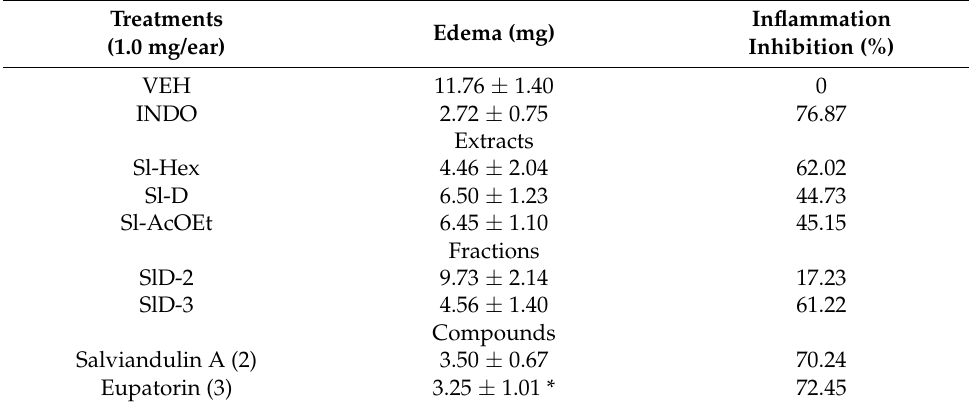
Table 5. Anti-inflammatory activity of Salvia lavanduloides .